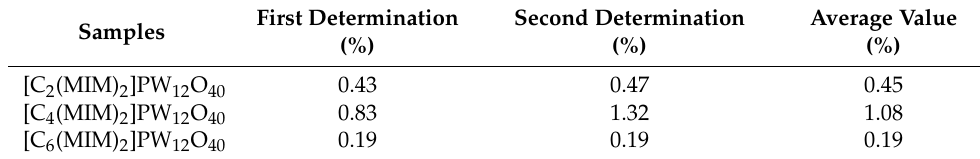
Table 1. The moisture in the samples.